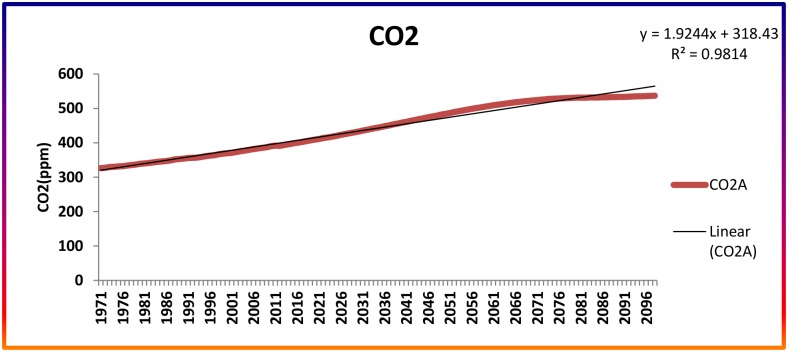
CO2 levels from RCP 4.5 of IPCC.